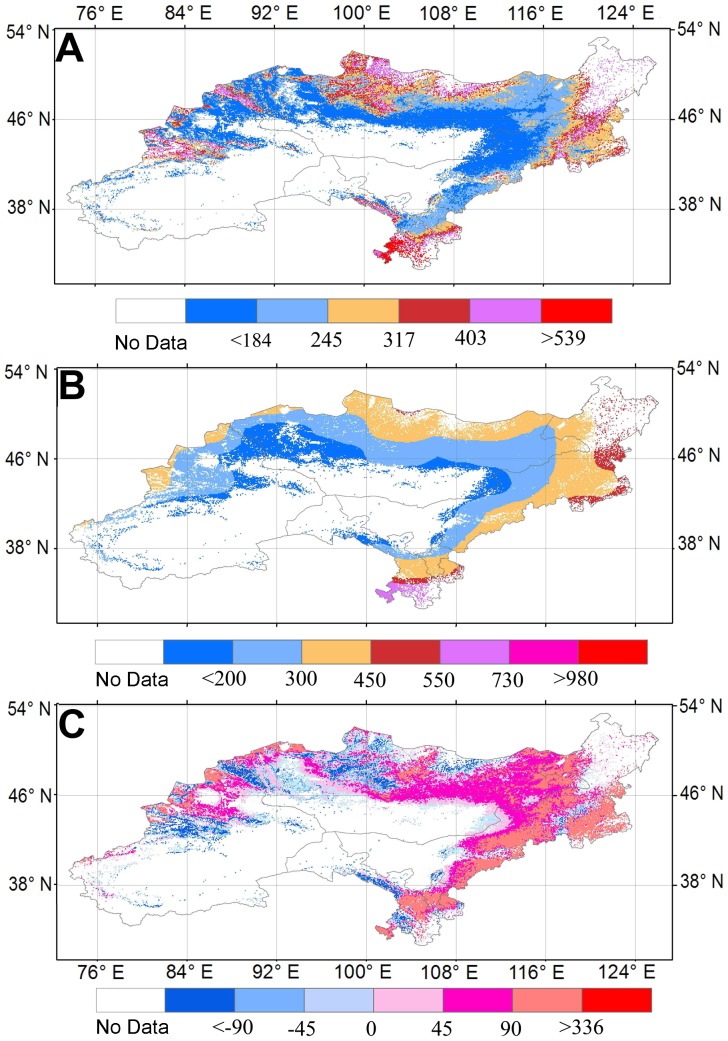
Maps of multi-year (1982–2009) mean annual evapotranspiration (ET), precipitation, and water balance.(A)–(C) show the regression tree ET, GPCP precipitation and water balance derived from GPCP precipitation, respectively.